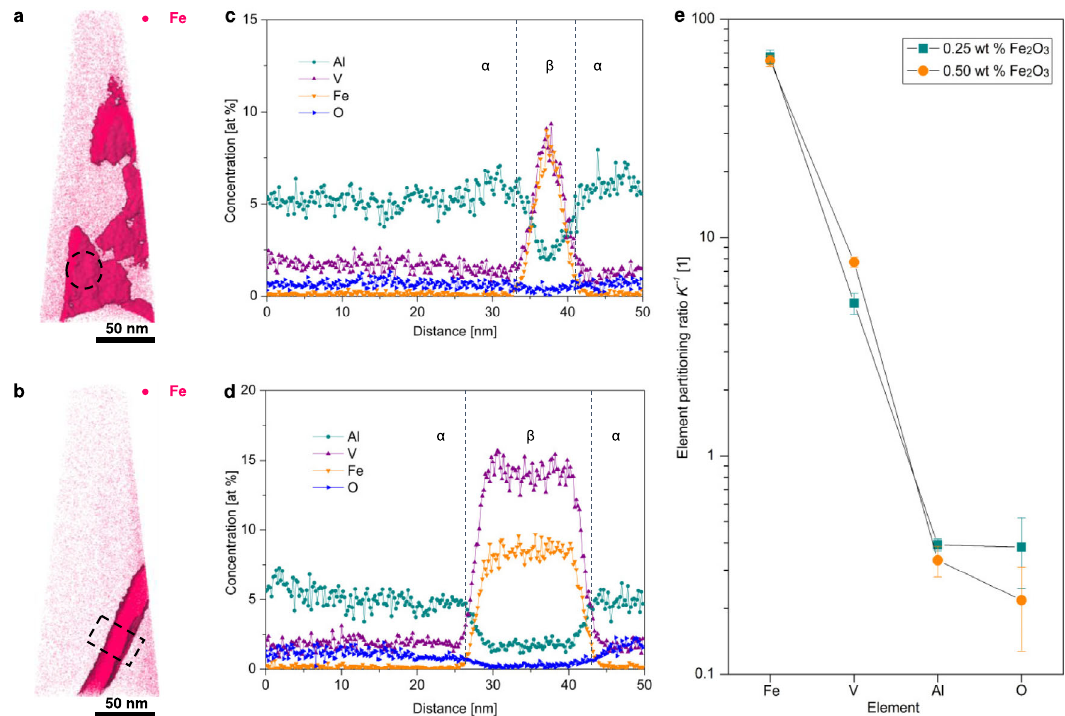
Fig.4|Atomprobetomography(APT)characterizationofthenewlydeveloped alloys.a , b